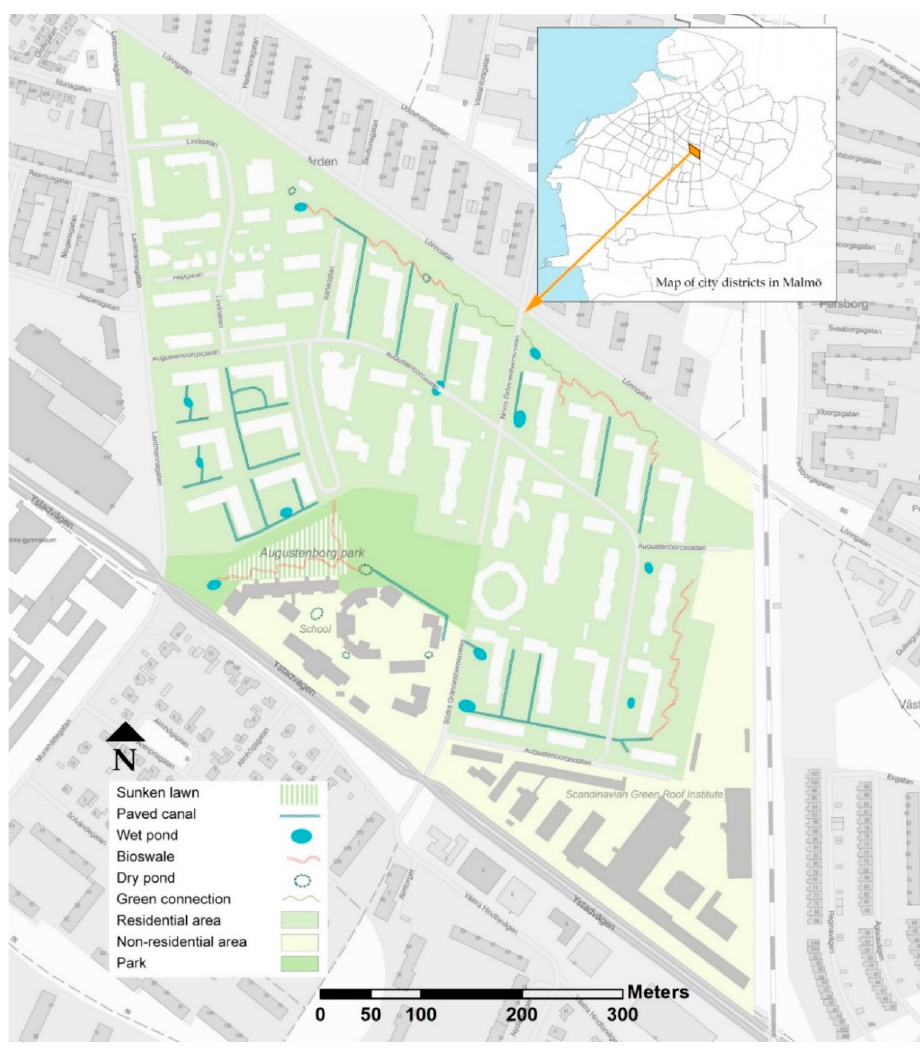
Figure 1. Map of Augustenborg showing blue-green solutions. Source: [16].